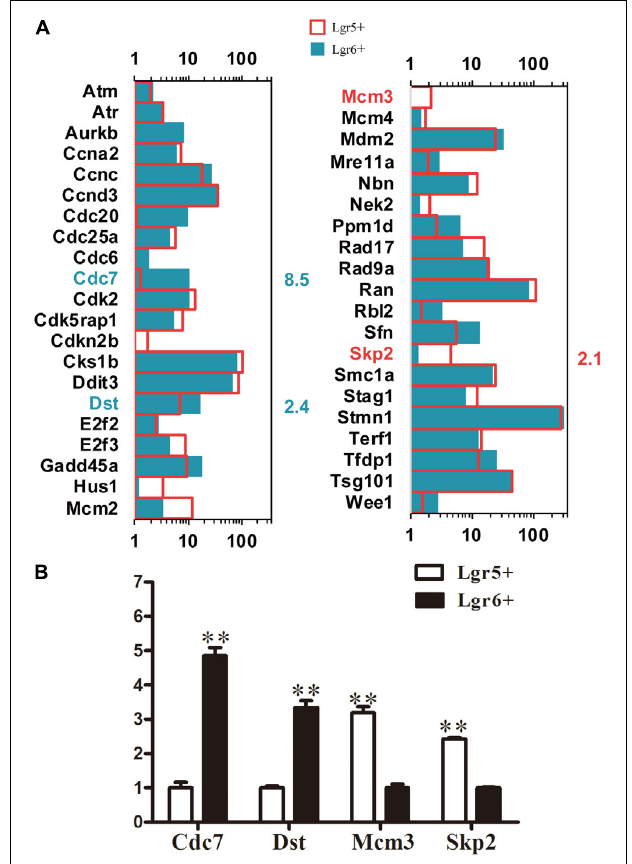
FIGURE 6 | Cell cycle genes in Lgr5+ progenitors and Lgr6+ progenitors. (A) The expression of genes involved in the cell cycle in Lgr5+ progenitors and Lgr6+ progenitors. The significantly differentially expressed gene names in Lgr5+ progenitors and Lgr6+ progenitors are labeled in red and blue, respectively. The number in red on the right of each panel represents the fold difference in expression in Lgr5+ progenitors versus Lgr6+ progenitors, and the number in blue on the right of each panel represents the fold difference in expression in Lgr6+ progenitors versus Lgr5+ progenitors. (B) q-PCR analysis of the cell cycle genes. ∗∗ p < 0.01, n =